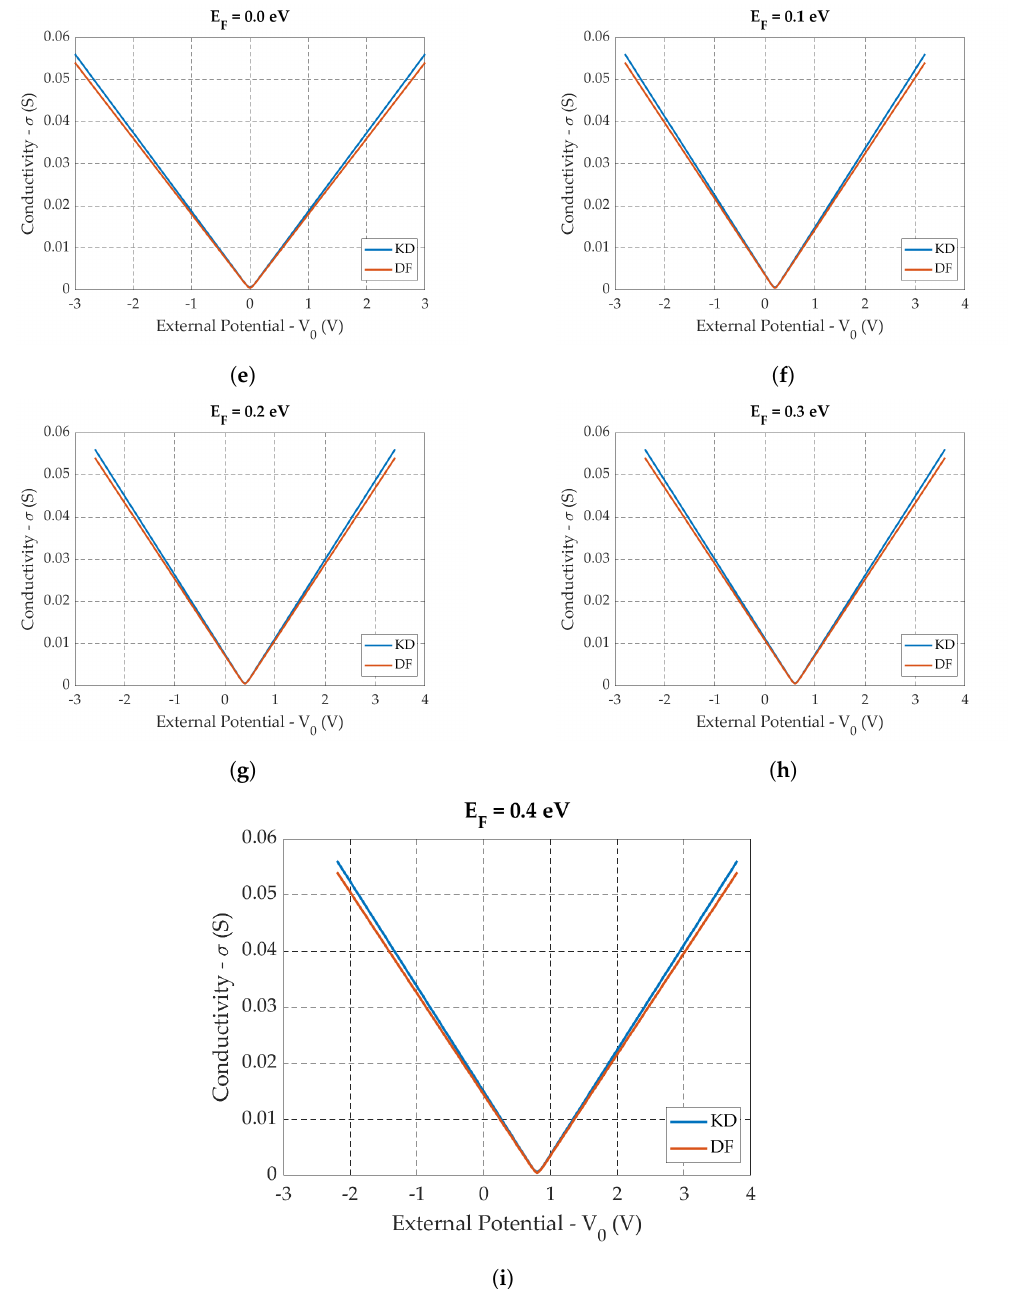
Figure 4. Conductivity of graphene calculated: (i) by the Dirac formulation (DF) of present method (red lines), and (ii) by the Kubo–Drude formulation (blue lines), for different values of the intrinsic Fermi level µ 0 = 2 E F (eV), and for V 0 ∈ [ − 3,3 ]